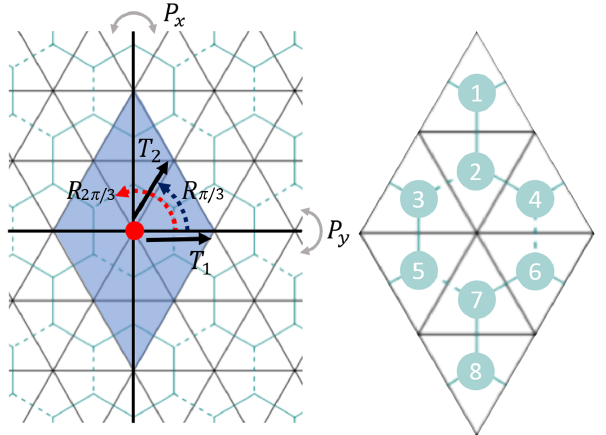
FIG. 3. Crystal symmetry of the triangular lattice, the nearest neighbor hopping amplitudes of the vortices, and the unit cell after taking into account of the sign of t ij